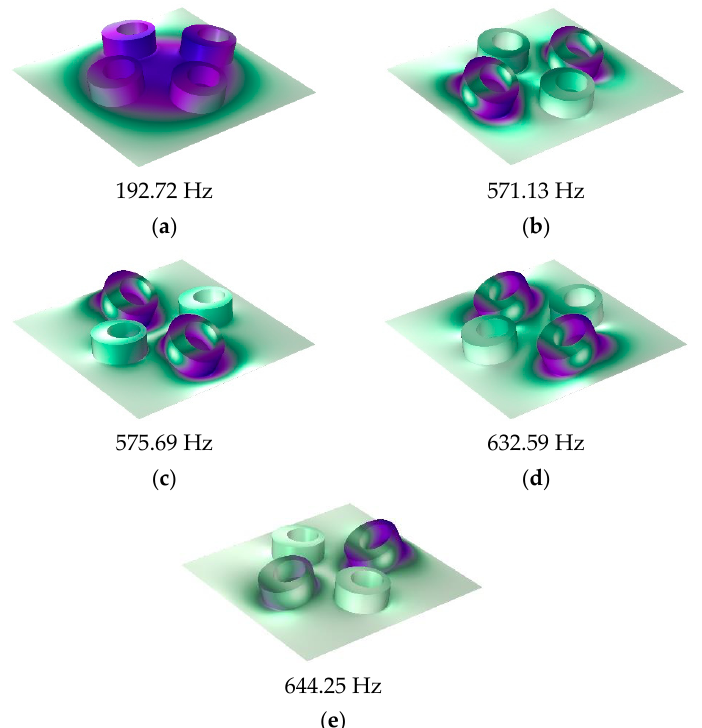
Figure 10. Eigenmodes of the four-mass-loaded membrane: ( a ) 192.72 Hz, ( b ) 571.13 Hz, ( c ) 575.69 Hz, ( d ) 632.59 Hz, and ( e ) 644.25 Hz.